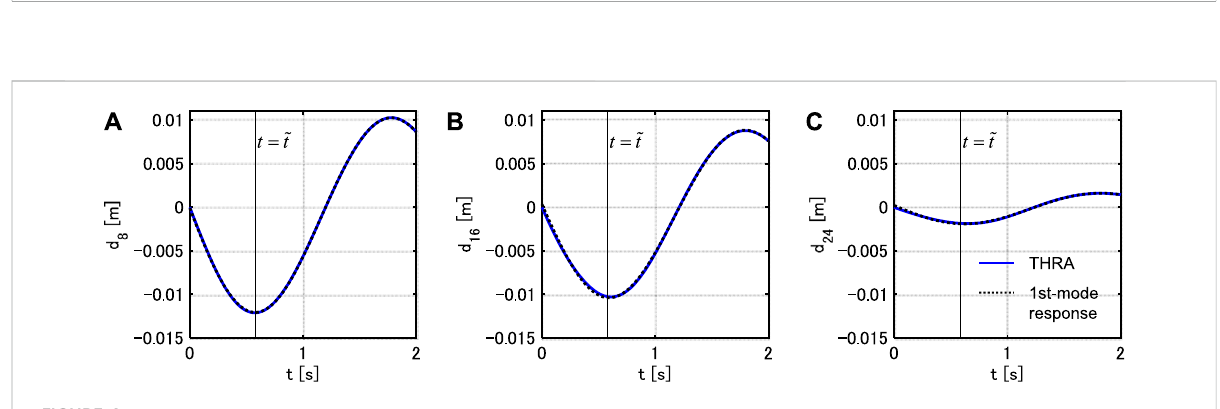
FIGURE 4 Interstory drift response time-history under PSI (Model 1), (A) 8-th story, (B) 16-th story, (C) 24-th story.